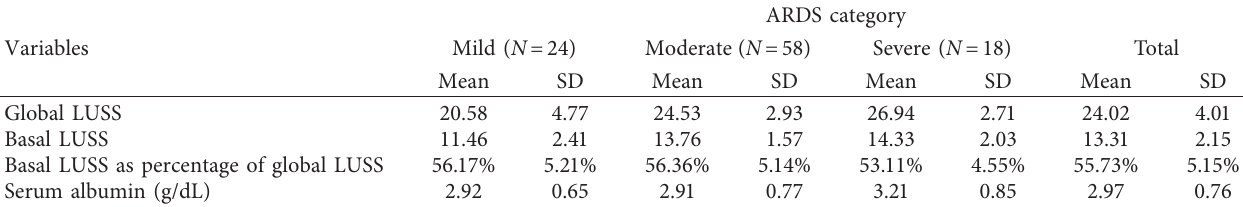
Table 3: Depiction of the LUSS and albumin level in the three categories of ARDS. Variables